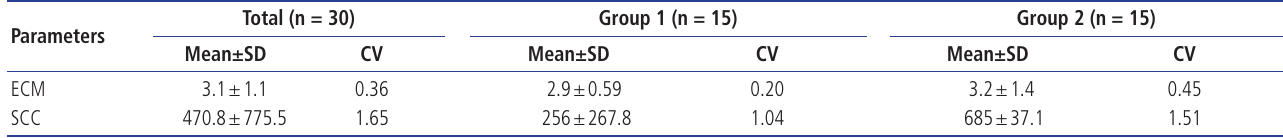
Table 5. Means, standard deviations and coefficient of variation for cellularity parameters of buffalo milk herd and for the groups at the beginning of lactation (1) and end of lactation (2)